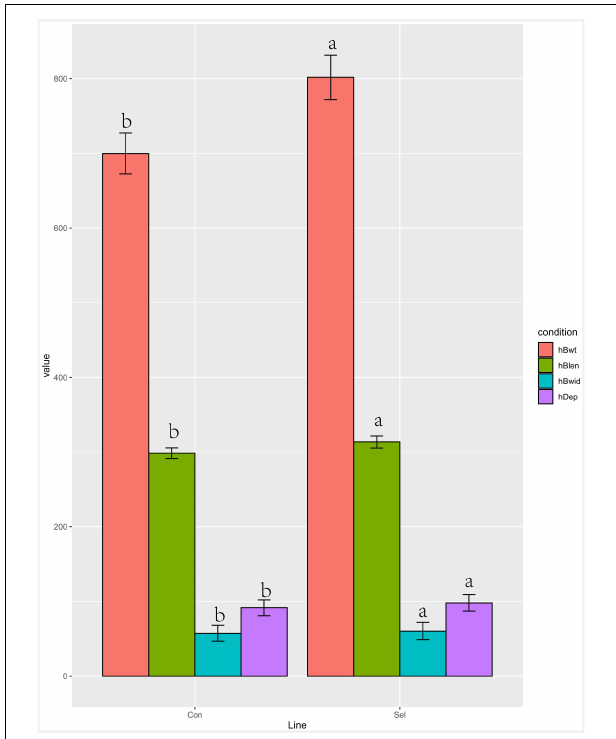
FIGURE 1 | Growth performance comparison of the selection (Huanghe carp new strain 4th generation) and control lines. Different characters in the same color indicate a significant difference for a given growth parameter. Body weight is hBwt, length is hBlen, width is hBwid, and depth is hDep. T -test was used to examine the significance of differences between the selection and control groups (P